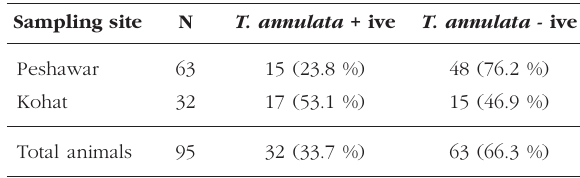
Table I. – Sampling districts along with the total number of cattle samples collected (N) from each site. Prevalence of Theileria annu - lata is given in parenthesis. ANOVA results revealed a significant effect (P = 0.053) of location on parasite